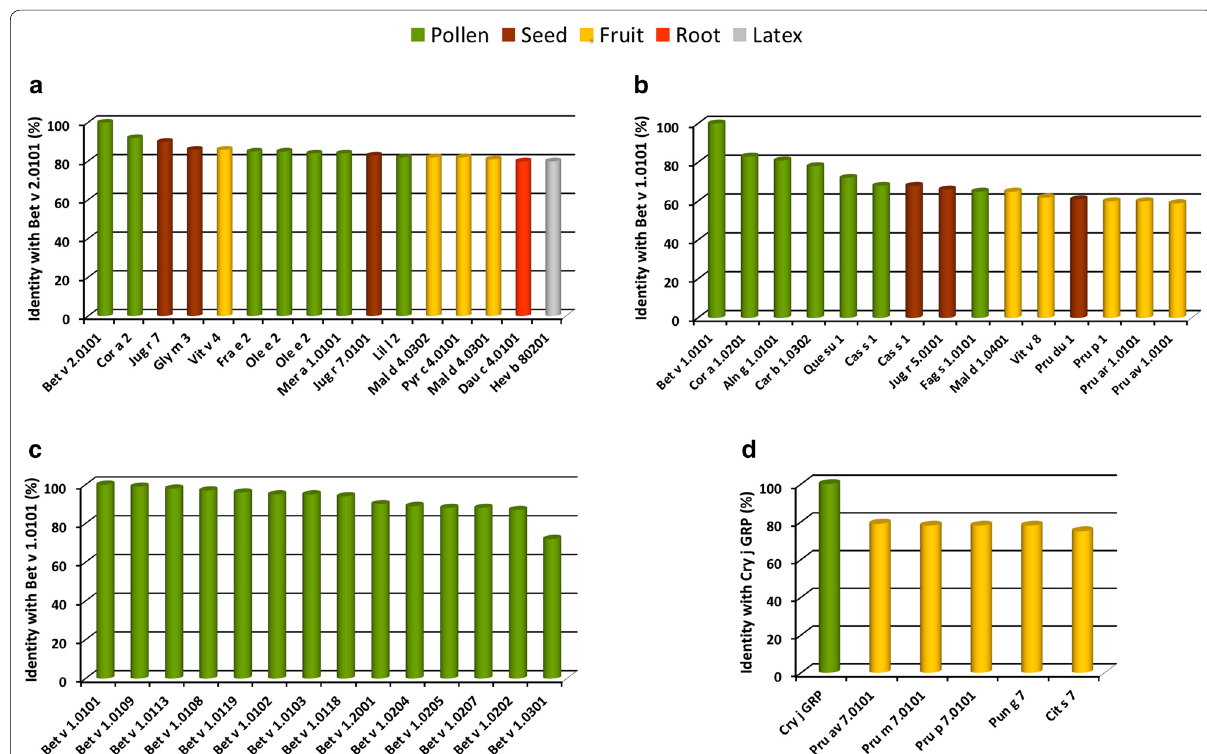
Fig. 2 Comparison of amino acid sequence identity percentage between different allergens. Bar colors highlight the plant source of allergens, namely green, brown, yellow, red and light grey are for pollen, seed, fruit, root and latex, respectively. The similarity searches were performed with the Allergome Aligner tool, using the Blast algorithm on the Allergome platform (https ://www.aller gome.org). The amino acid sequence of Bet v 1.0101 ( b and c ), Bet v 2.0101 ( a ) and Cry j GRP ( d ) were used as query sequences. The allergens shown in a and b were selected as representative